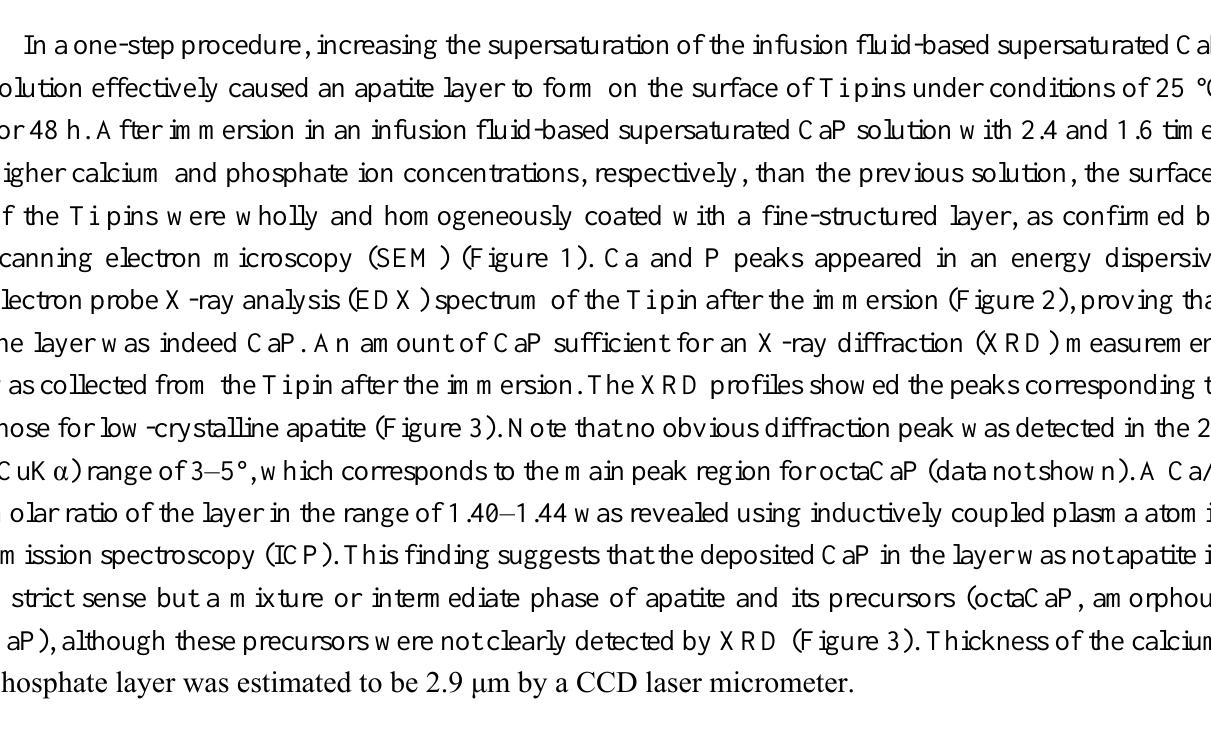
Figure 1. SEM images of the surfaces of Ti pins before ( a ) and after ( b ) immersion in the CaP solution at 25 °C for 48 h. Scale bar, 2 μm.